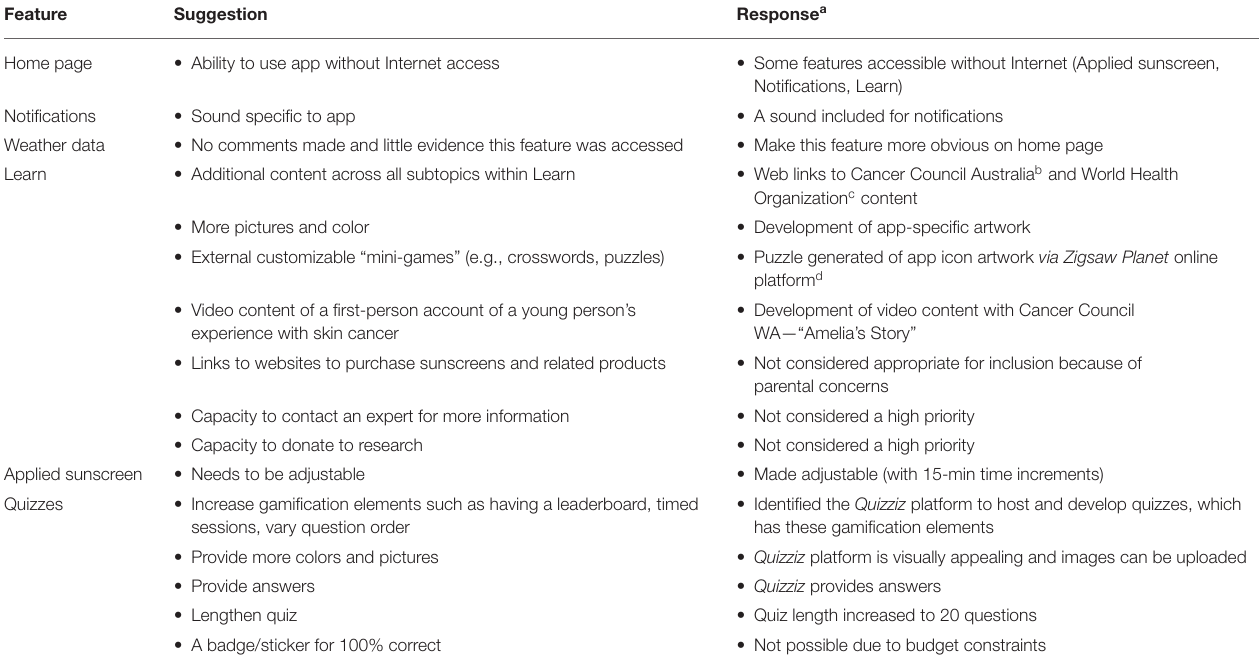
TABLE 4 | Suggestions to improve wireframe from co-researchers attending Workshop 2 for development of the Sun Safe app.